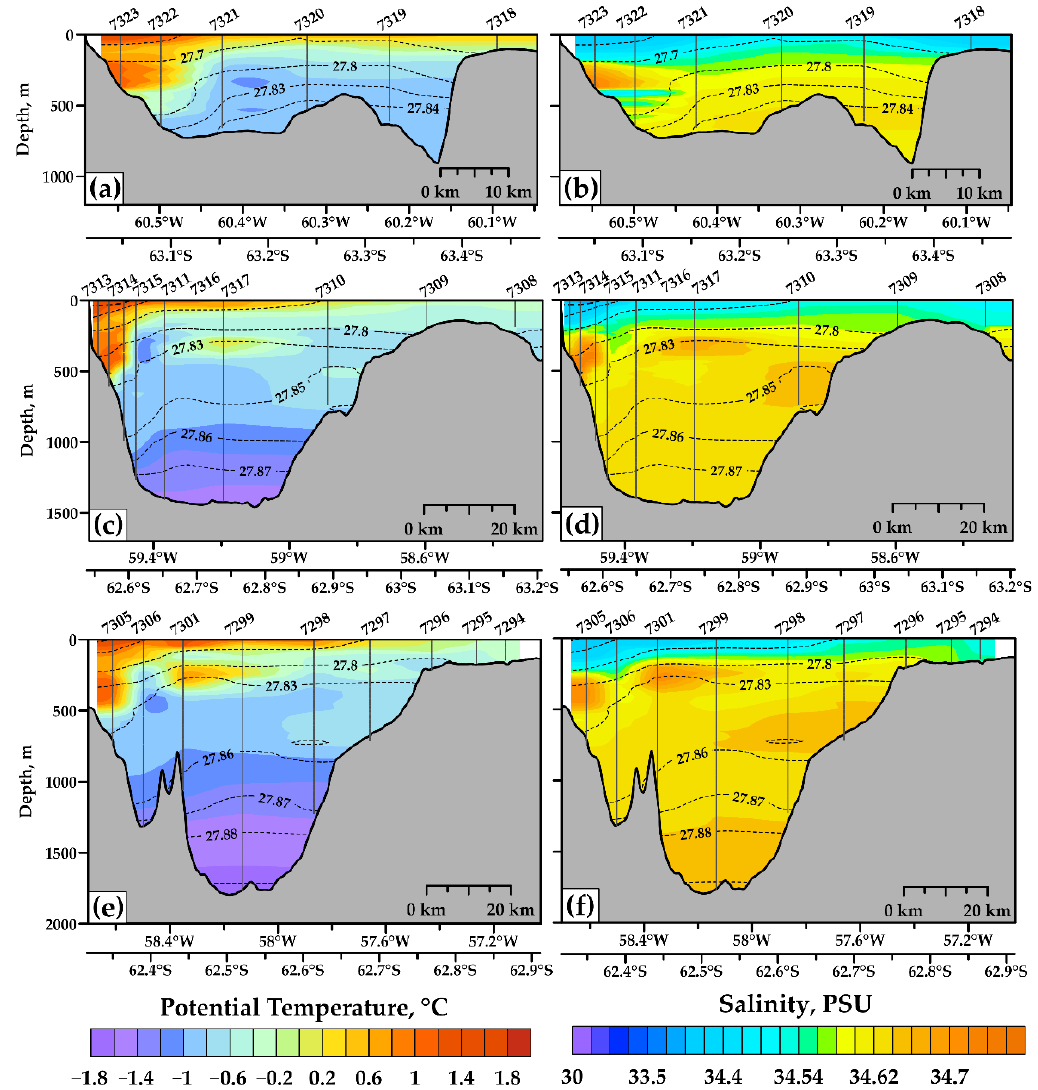
Figure 4. ( a , c , e ) Potential temperature and ( b – f ) salinity distributions at three sections across the Bransfield Strait. Data for ( a , b ) Section 1, ( c , d ) Section 2, and ( e , f ) Section 3. Isolines of potential density anomalies shown with dashed contours. Locations of CTD stations are indicated with solid lines. The bottom relief is shown according the GEBCO2021 database.